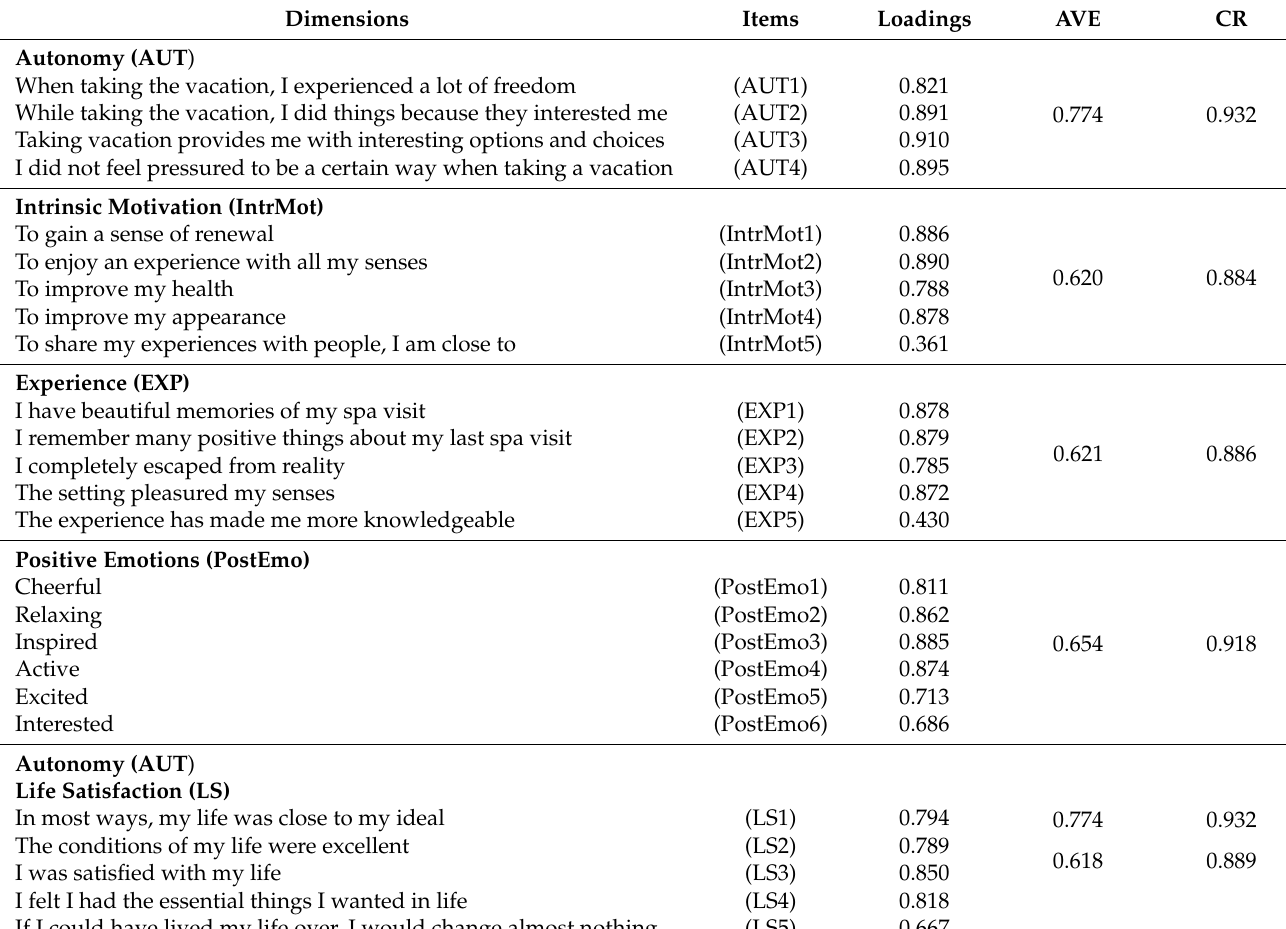
Table 3. Results of Confirmatory Factor